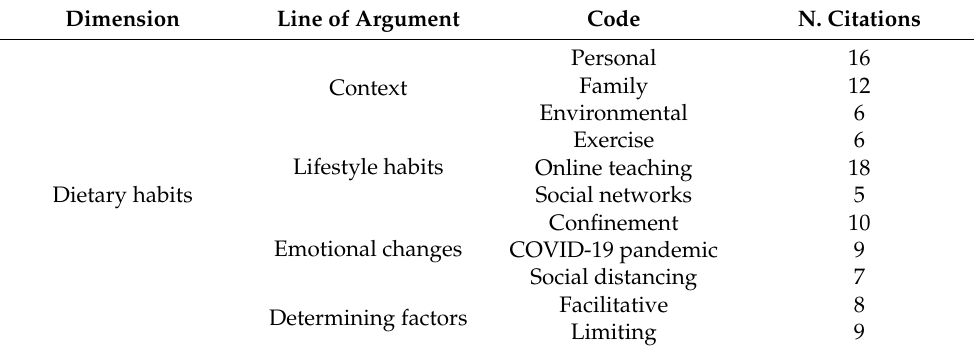
Table 2. Description of the categories, codes, and number of citations produced by analysis using Atlas ti. Dimension Line of Argument Code N. Citations Personal 16 Family 12 Context Environmental 6 Exercise 6 Lifestyle habits Online teaching 18 Dietary habits Social networks 5 Confinement 10 Emotional changes COVID-19 pandemic 9 Social distancing 7 Facilitative 8 Determining factors Limiting